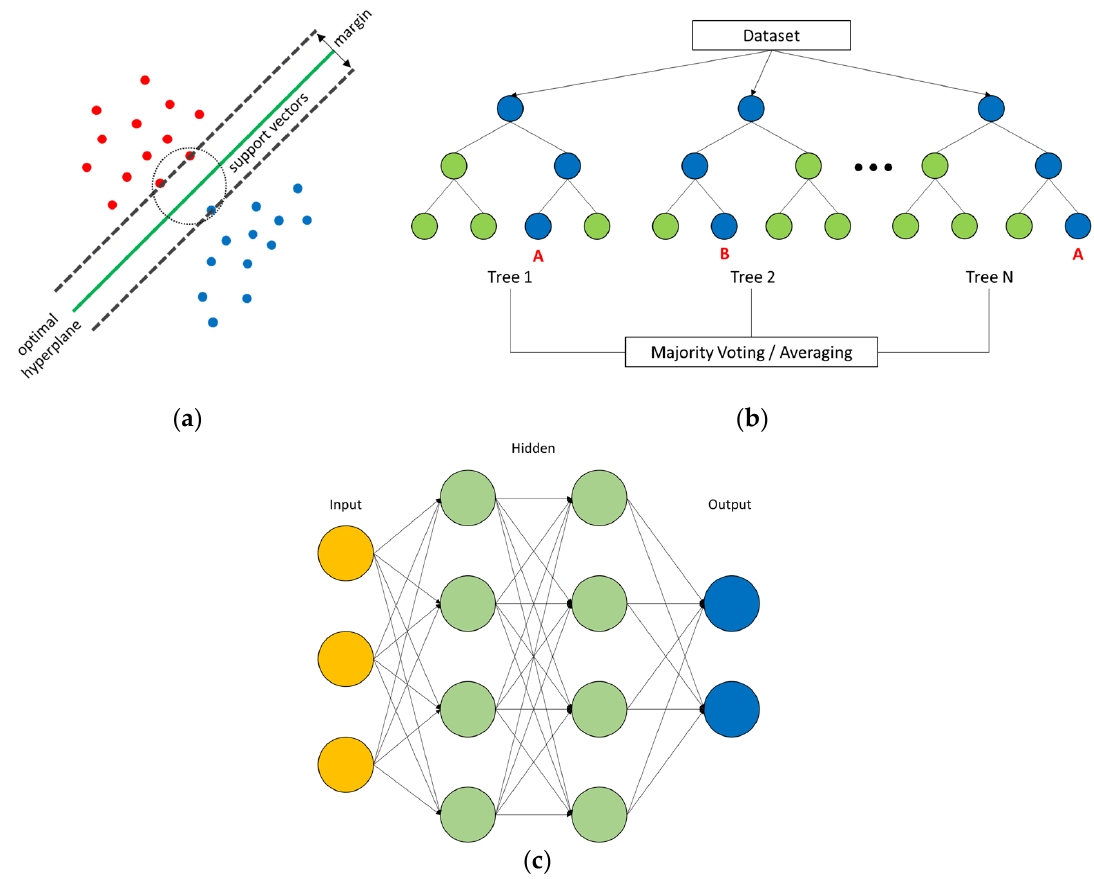
Figure 5. Schematic images of machine learning (ML) methods: ( a ) support vector machine (SVM), ( b ) random forest (RF), and ( c ) deep neural network (DNN).